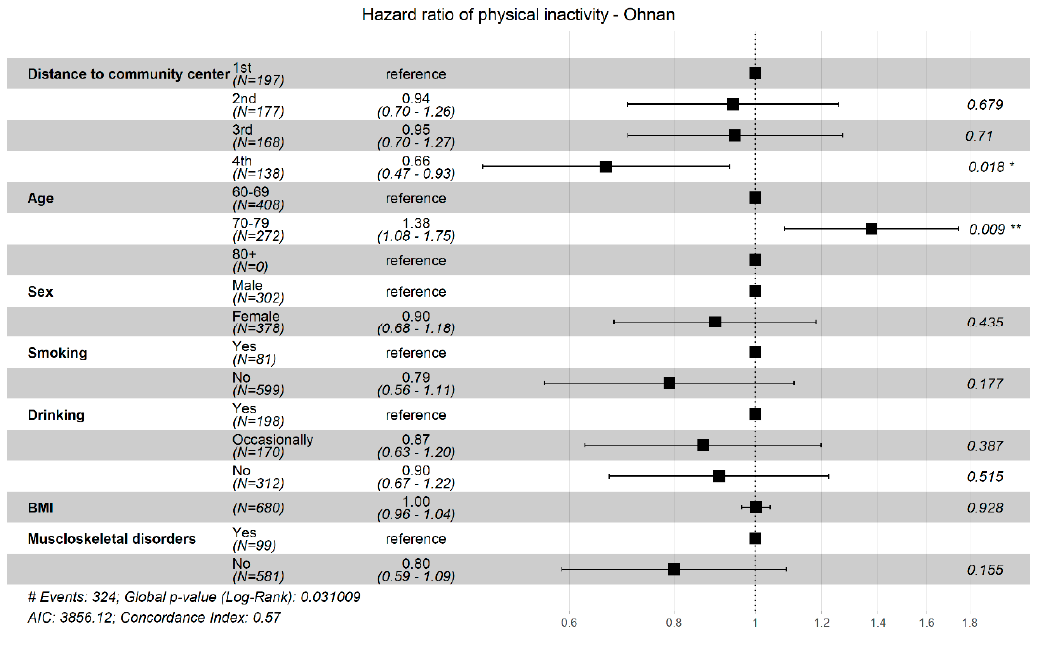
Figure 1. Hazard ratio of physical inactivity by quartile category of distance to community center in Ohnan. Quartile 1 (1st) = 0.97, 835 meter (m); Quartile 2 (2nd) = 835, 1540 m; Quartile 3 (3rd) = 1.540, 3.030 m; Quartile 4 (4th) = 3030, 11,200 m.